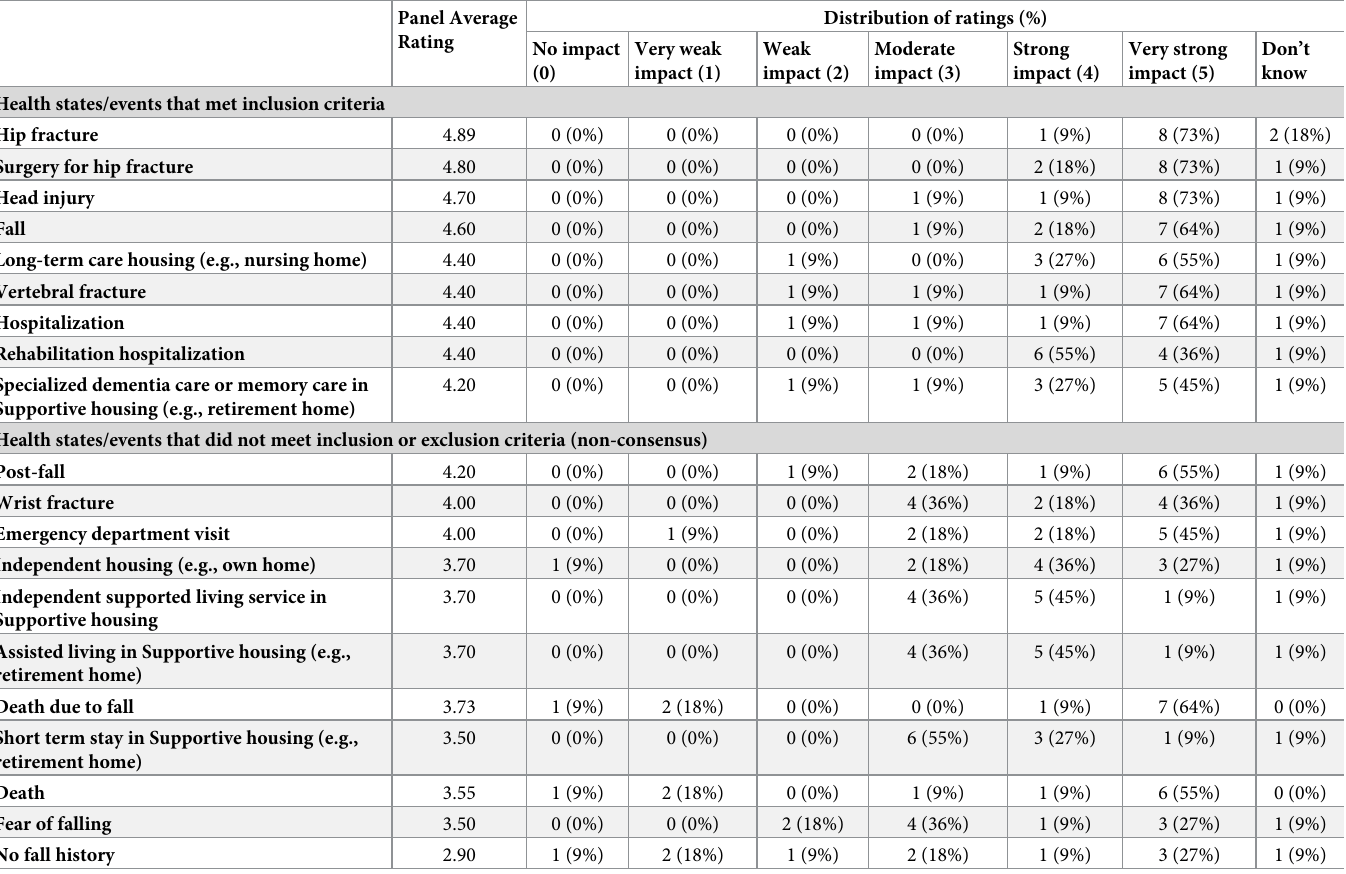
Table 2. Summary of health states/events ratings from the first Delphi